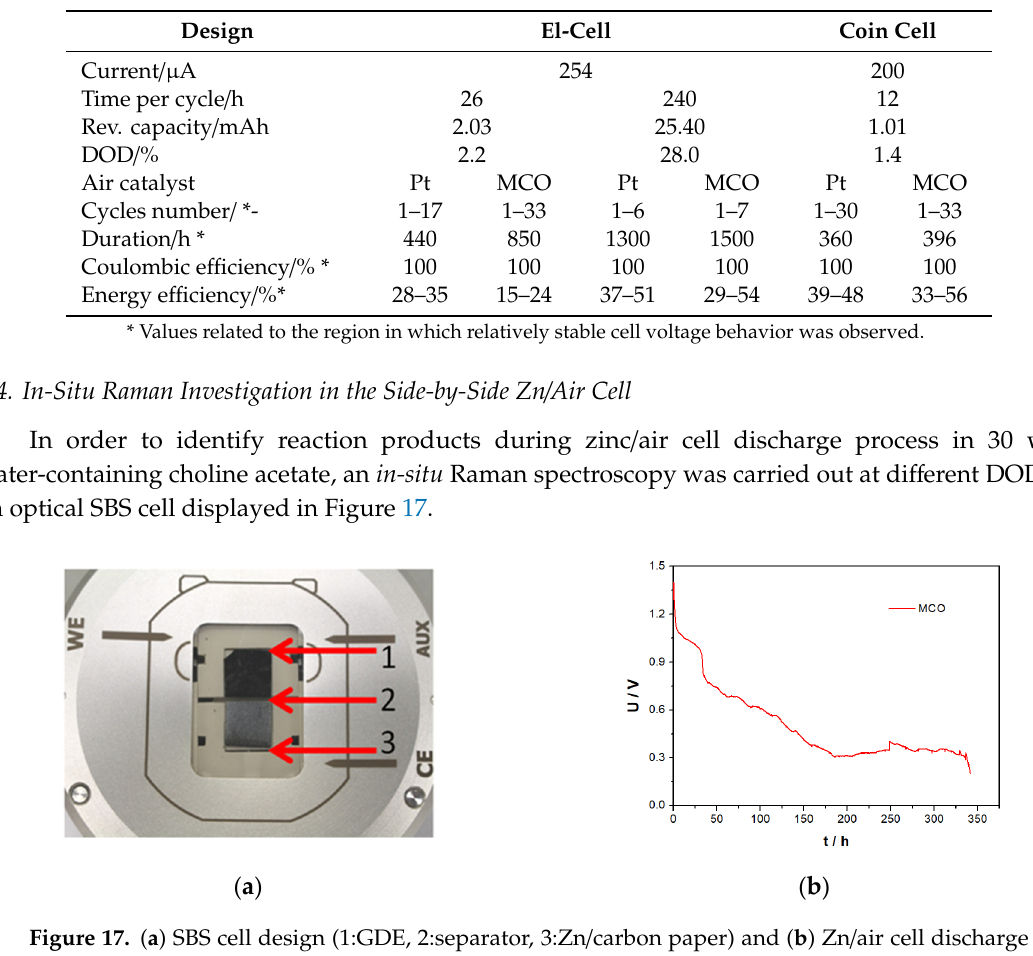
Table 4 summarized all results from Zn/air charge/discharge experiments of this work. Best performance in terms of test duration, reversible capacity, and energy efficiency were yielded in El-cell design with an MCO air catalyst during a 100 h charge/discharge protocol. Table 4. Summary of relevant results of Zn/air charge/discharge experiments at 100 µA cm − 2 (2.8